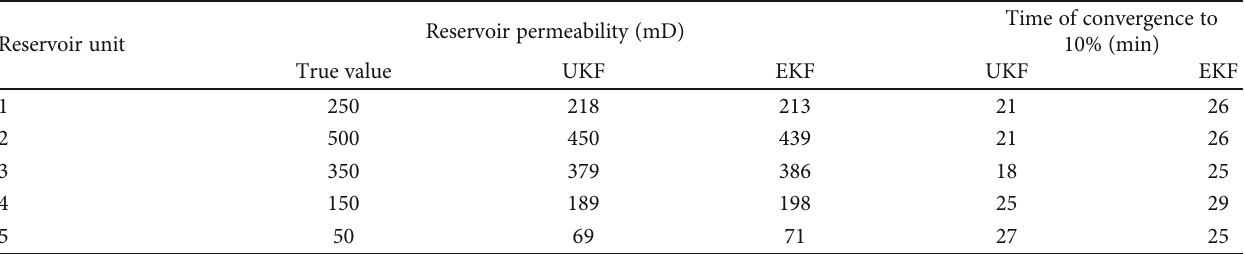
Figure 13: Comparison between EKF and UKF of the true and estimated value (case 1). Table 2: Comparative analysis of EKF and UKF estimated